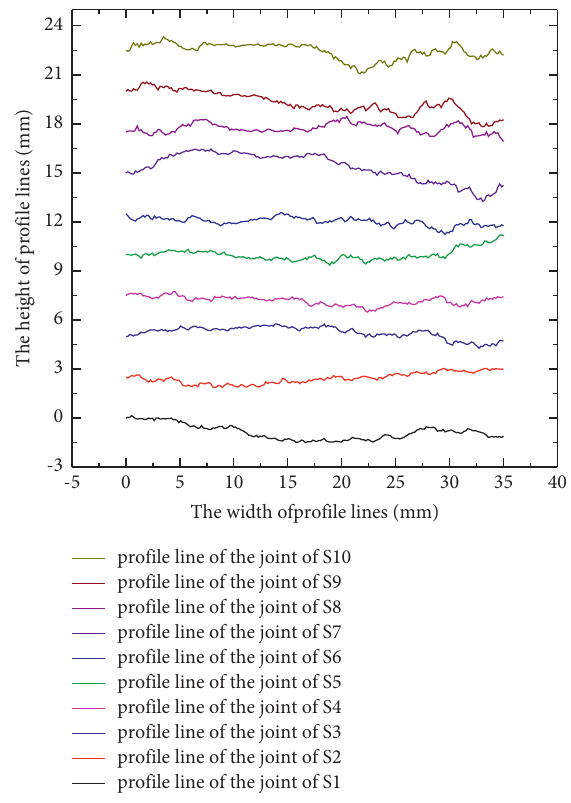
Figure 2: Profile lines of the surfaces of joints of the